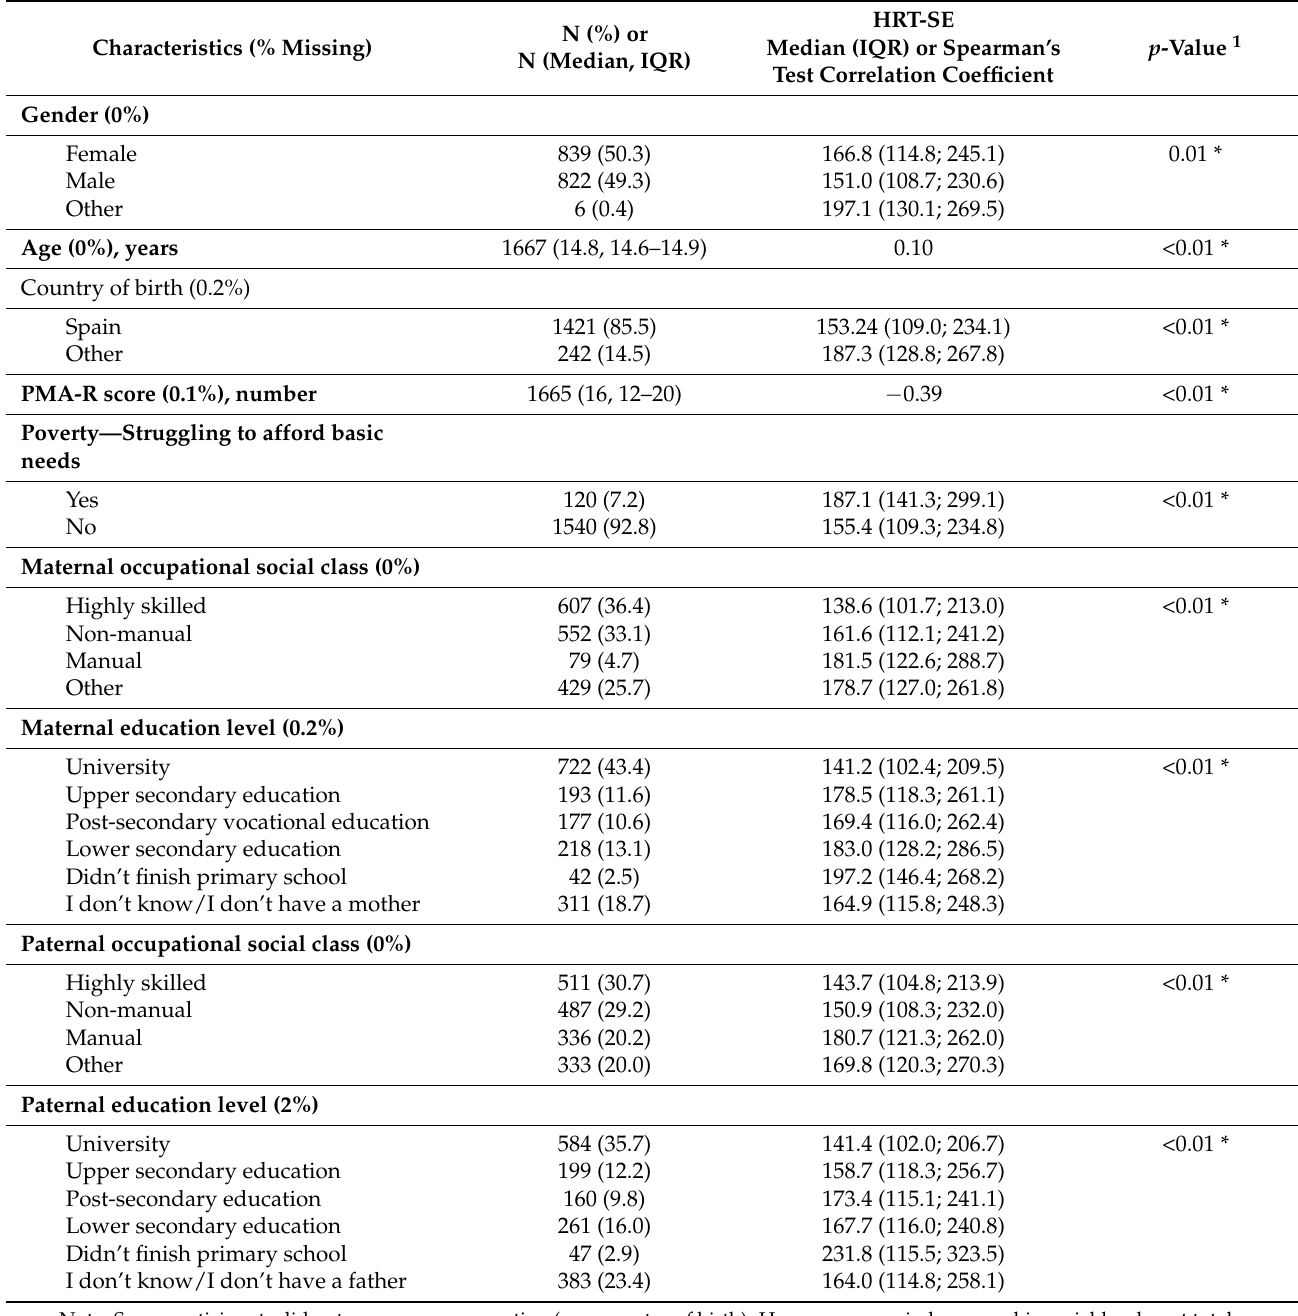
Table 2. Attentiveness (HRT-SE) according to participants’ sociodemographic characteristics ( n = 1667).